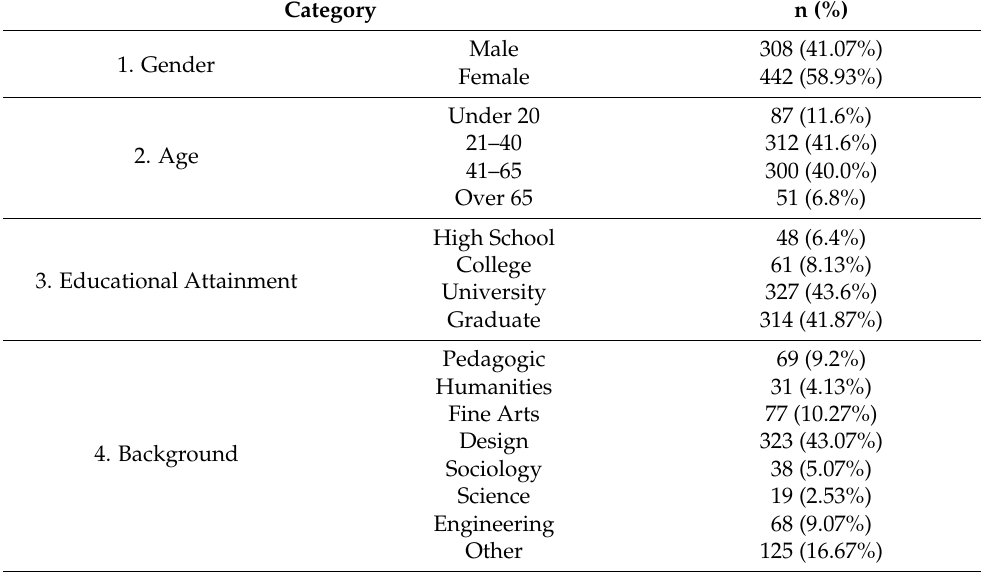
Table 1. Profiles of the